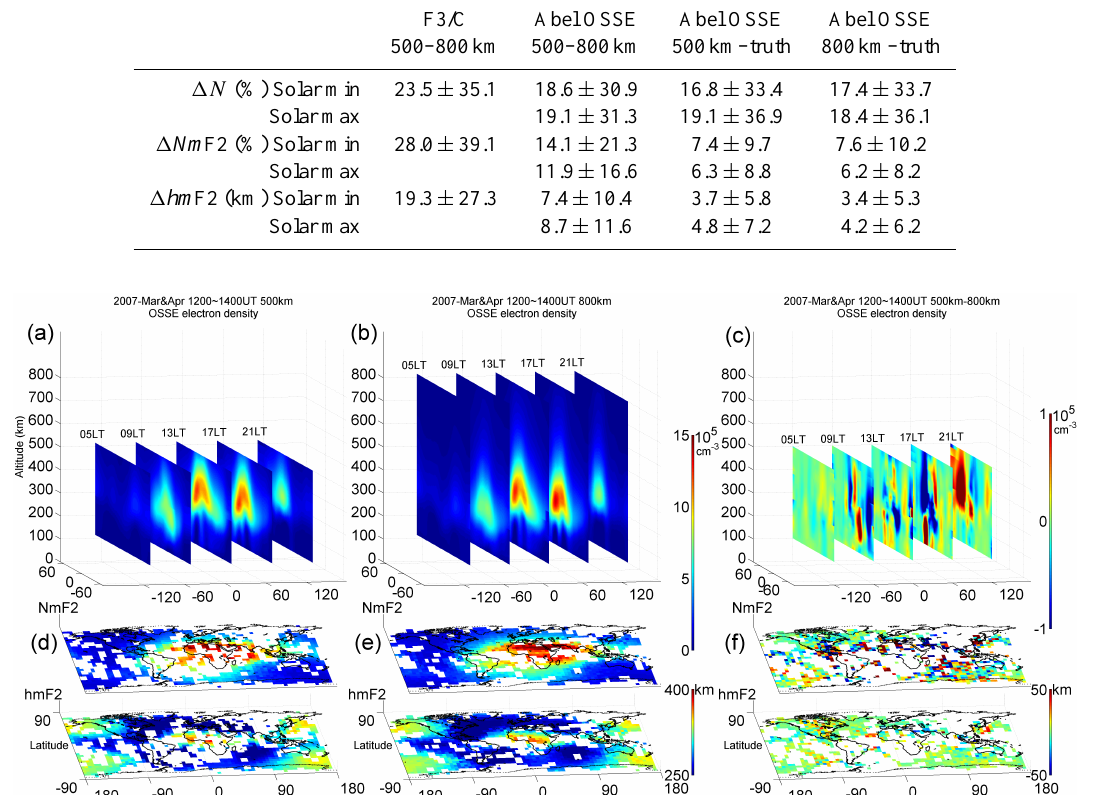
Figure 4. The Abel inversion OSSE electron density, Nm F2, and hm F2 observed from 500 and 800km altitude satellites, and their difference during 12:00–14:00UT in March and April of 2007. (a) OSSE electron density observed from 500km altitude, (b) OSSE electron density observed from 800km altitude, and (c) their difference. (d) OSSE Nm F2 and hm F2 observed from 500km altitude, (e) OSSE Nm F2 and hm F2 observed from 800km altitude, and (f) their